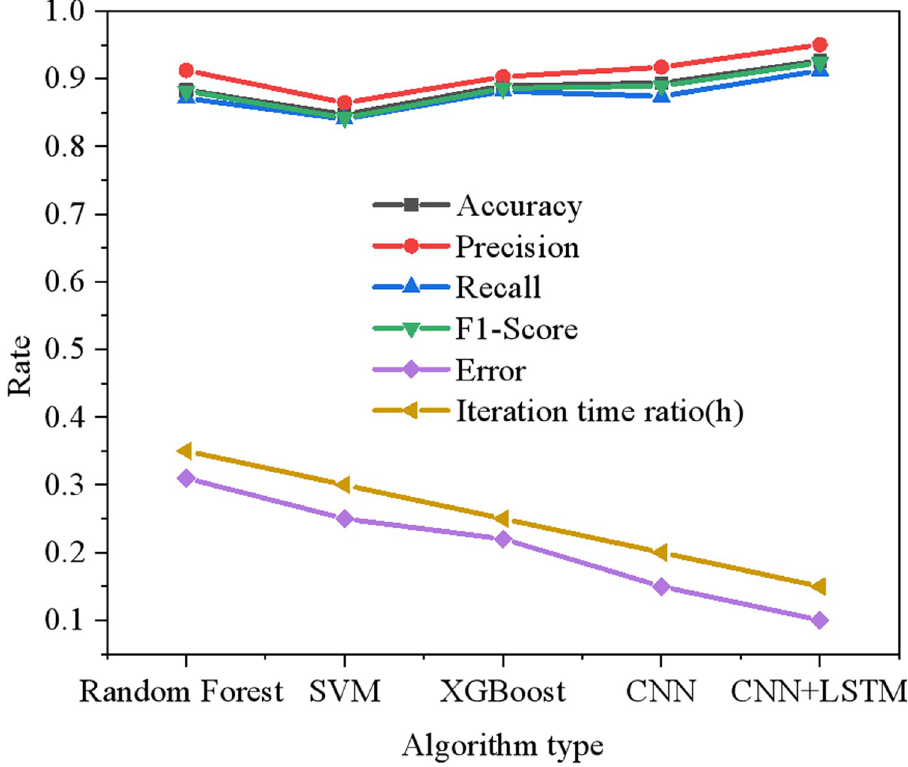
Fig 14. Comparison of results of different